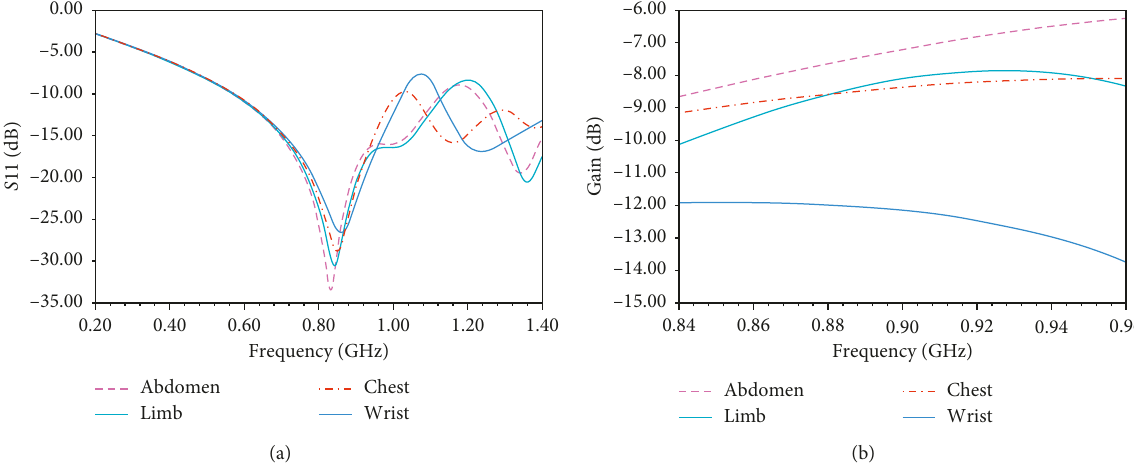
Figure 20: Simulated S 11 (a) and gain (b) of the second epidermal proposed tag placed onto four reference layers models of some body